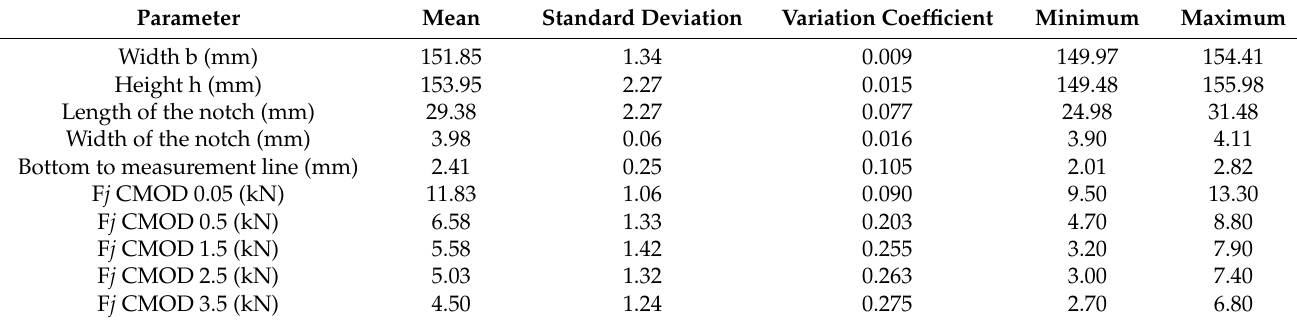
Table 3. Results of the statistical analysis for concrete with steel fibre A.